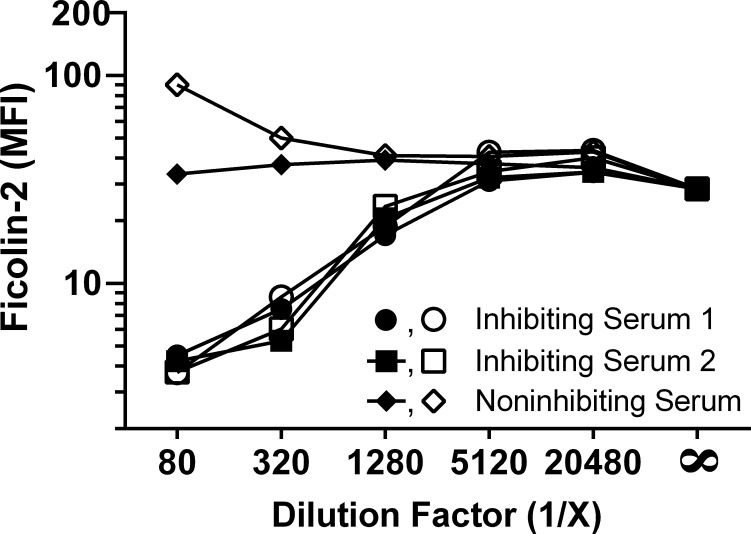
Some older adults’ sera have heat-resistant ficolin-2 inhibition.Sera were inactivated at 56 °C (solid symbols) or held at room temperature (open symbols) for 45 minutes prior to serial dilution, mixing with recombinant ficolin-2, and incubation with serotype 11A pneumococci. The elevated signal at lower dilutions of the noninhibiting serum sample without heat inactivation is accounted for by the innate ficolin-2 within this sample.